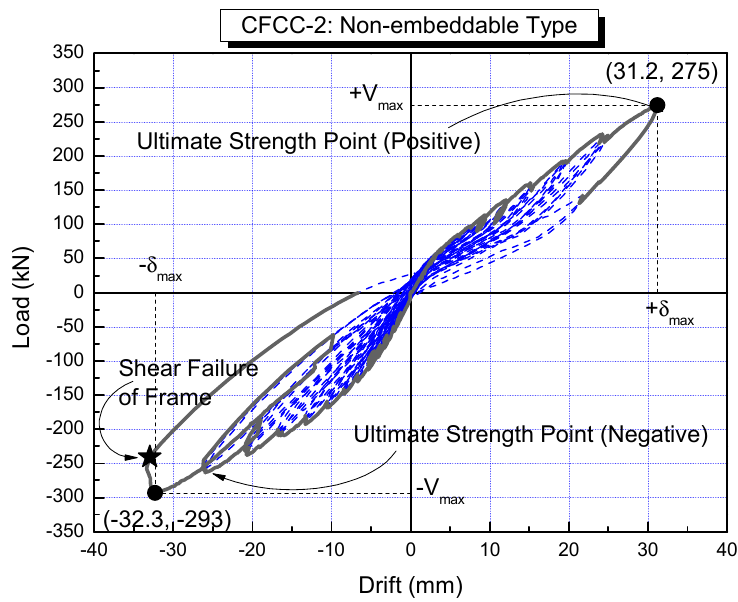
Figure 11. Load–drift relation for the CFCC-2 specimen.